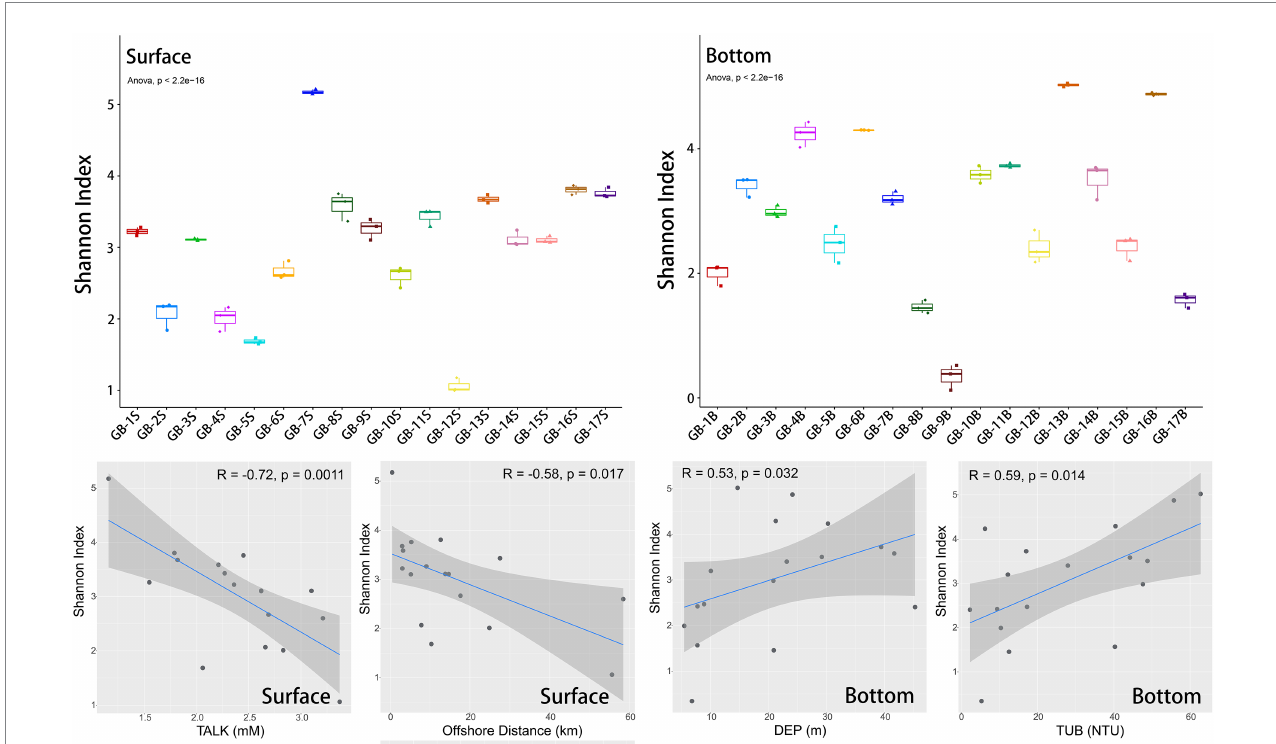
FIGURE 3 Alpha-diversity (Shannon index) of eukaryotic plankton in surface and bottom layers, and Spearman correlations between Shannon index and environmental factors. In each boxplot, from bottom to top, there are lower limit (minimum value), lower quartile (Q1), median value (Q2), upper quartile (Q3) and upper limit (maximum value). ANOVA test was used for comparison between groups.